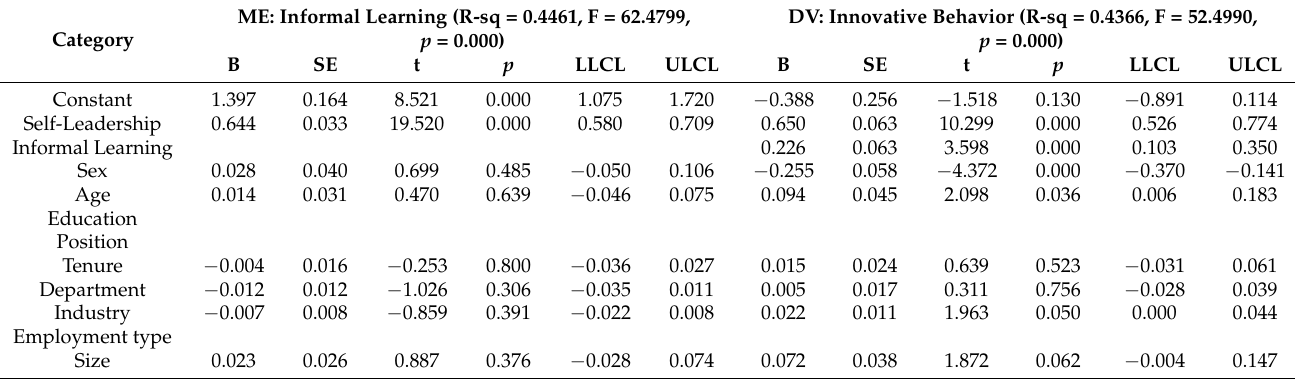
Table 4. Mediating effect of informal learning.